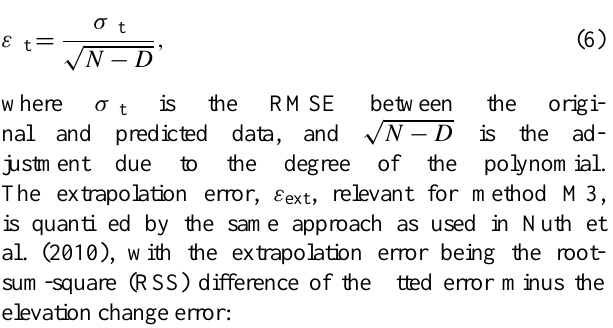
Figure 1. Spatial patterns of elevation changes of the five regions in the form of the satellite ground track coverage.